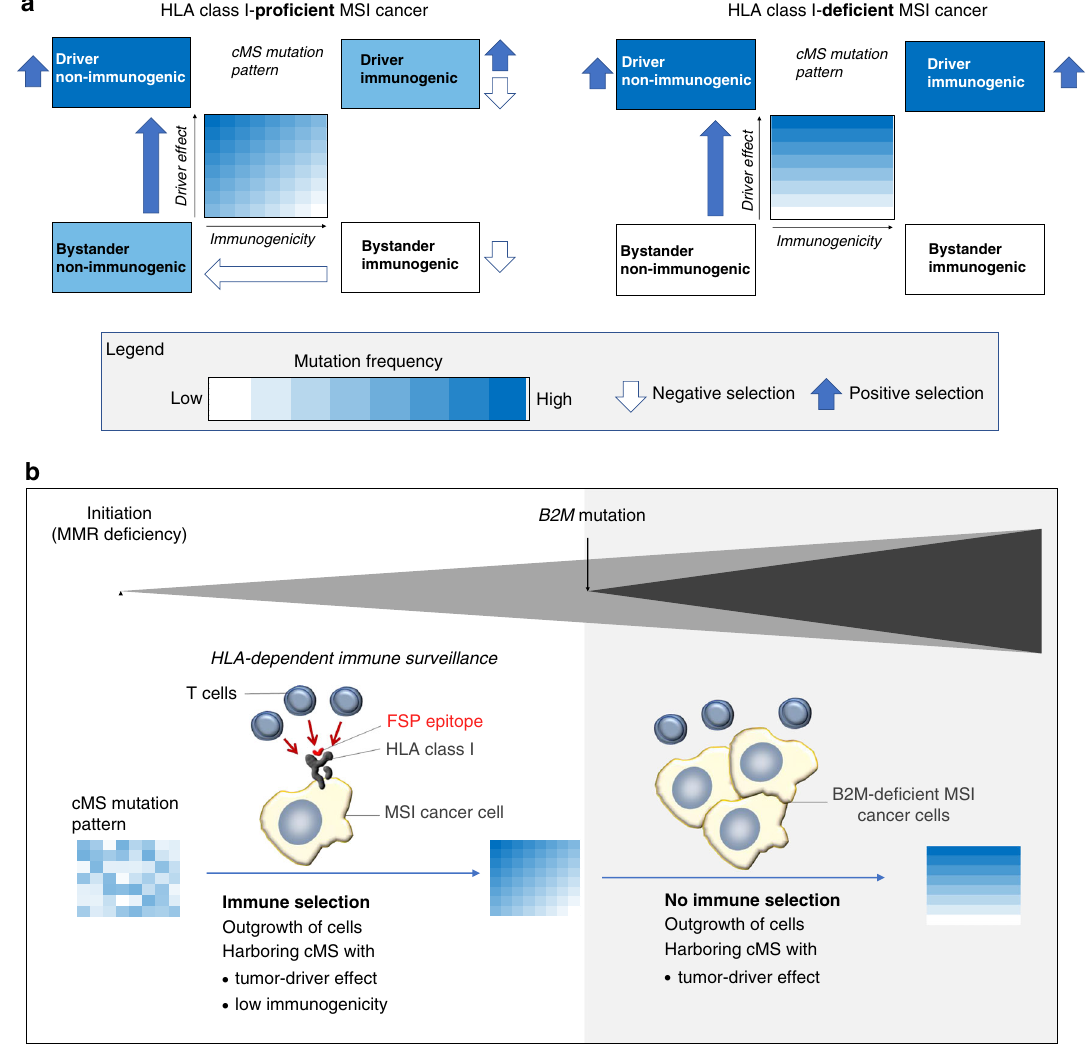
Fig. 6 In fl uence of immunoediting on cMS mutation patterns in MSI CRC. a Coding mononucleotide mutations in MSI cancer can lead to the inactivation of tumor-suppressor genes and therefore have a driver effect on tumor development. Simultaneously, the same mutations can trigger the generation of frameshift peptides with a certain immunogenicity. In the scheme, cMS are located in a two-dimensional lattice depending on the strength of the driver effect resulting from a cMS mutation ( y axis) and the immunogenicity of the respective frameshift peptide ( x axis). Color illustrates cMS mutation frequency, with dark blue representing high mutation frequency and white absence of mutations (according to heat map in Fig. 1a). The combination of positive selection (blue arrows) and negative selection (white arrows) pressure in B2M -wild-type tumors leads to highest frequencies for non- immunogenic driver cMS mutations and lowest frequencies for immunogenic non-driver cMS mutations (left panel). In B2M -mutant tumors, negative HLA class I-dependent selection is absent; therefore, expected mutation frequencies are independent from immunogenicity of frameshift peptides. b Scheme of MSI CRC evolution. B2M mutation can occur as a mechanism of immune evasion during tumor progression. B2M mutations lead to a breakdown of HLA class I-mediated antigen processing and therefore interferes with T cell-mediated elimination of MSI cell clones harboring immunogenic frameshift peptides (also see Supplementary Fig.